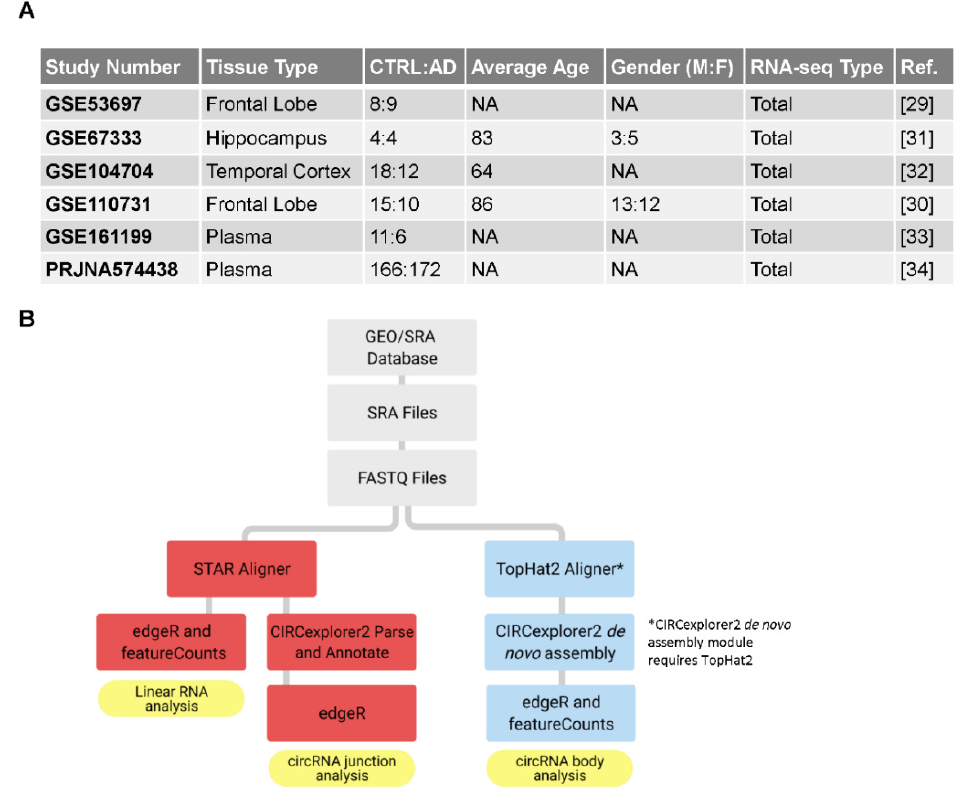
Figure 1. Datasets and workflow used in this study. ( A ) Each study that was used for gene expression analysis, including the brain region, number of samples, RNA sequencing type, and available subject demographics. ( B ) Workflow chart, starting with total RNA-sequencing data, alignment to the human genome, identification of circRNAs, and measurement of differential abundance.